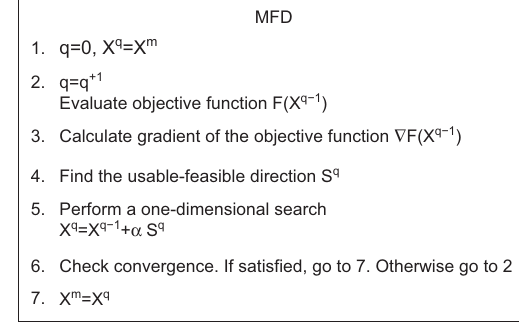
Figure 2 Flow chart of the modified feasible direction